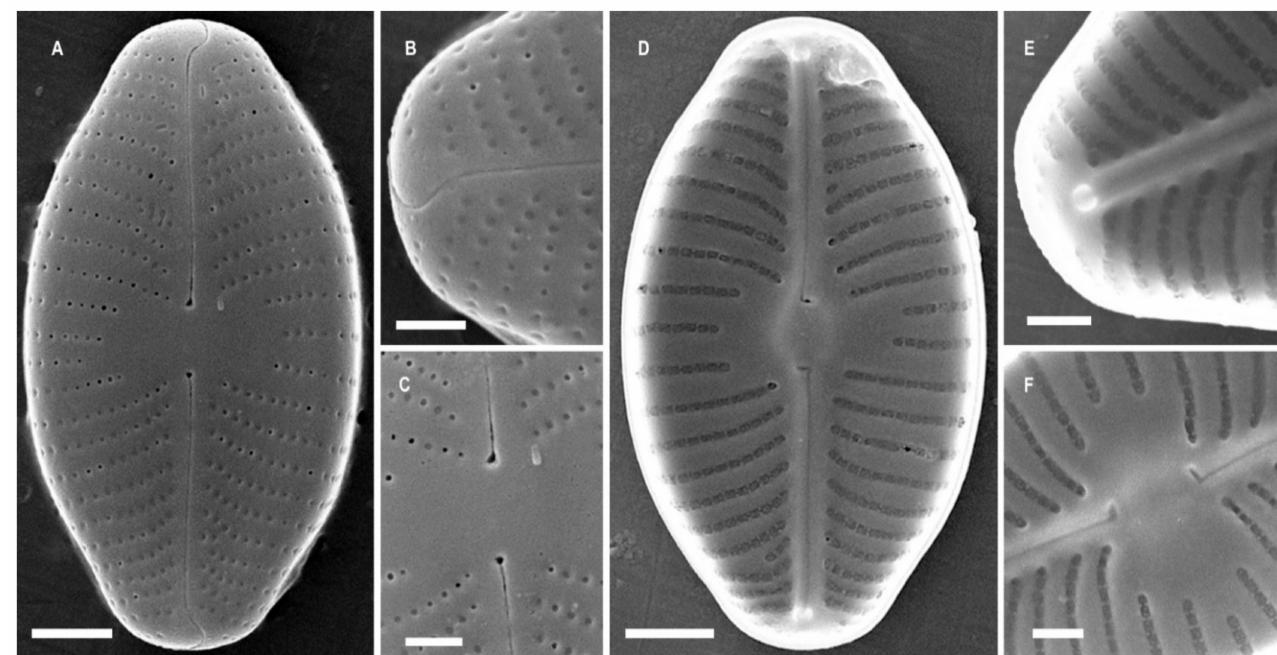
Figure 4. Placoneis baikaloelginensis Kezlya, Glushchenko, Kulikovskiy & Kociolek sp. nov. Strain B708, sample no. 01498. Scanning electron microscopy: ( A – C ) External views. ( D – F ) Internal views. ( A , D ) The whole valve. ( C , F ). Central area details. ( B,E ) Valves ends. Scale bars ( A , D ) = 5 µ m; ( B , C , E , F ) = 1 µ